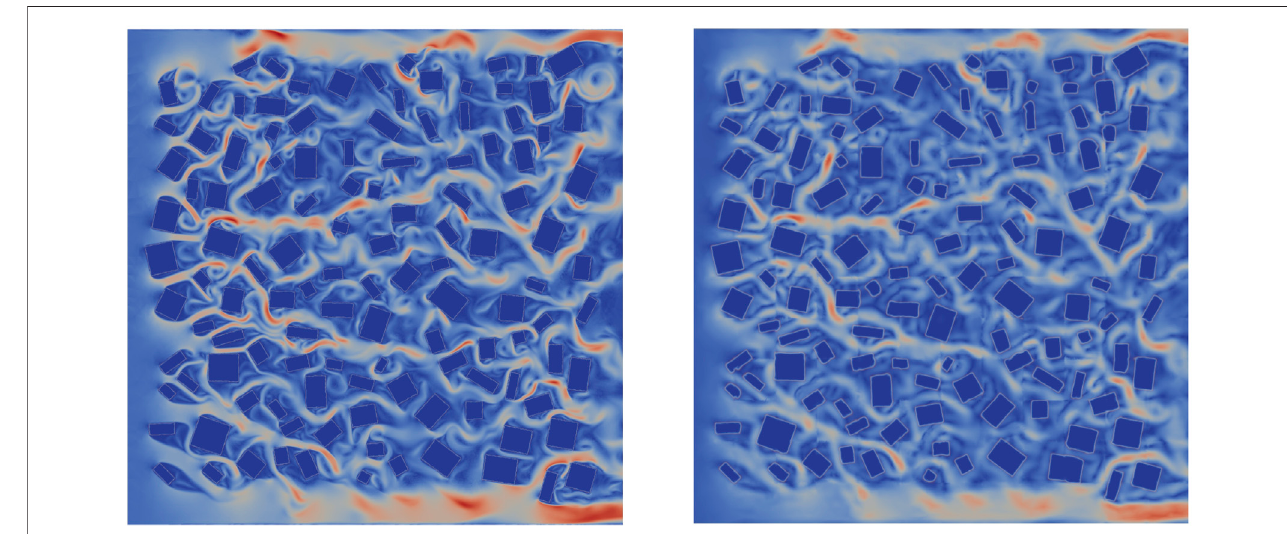
FIGURE 7 | The velocity magnitude at the 400th time level from the HFM (left) and the predictive adversarial network (right).